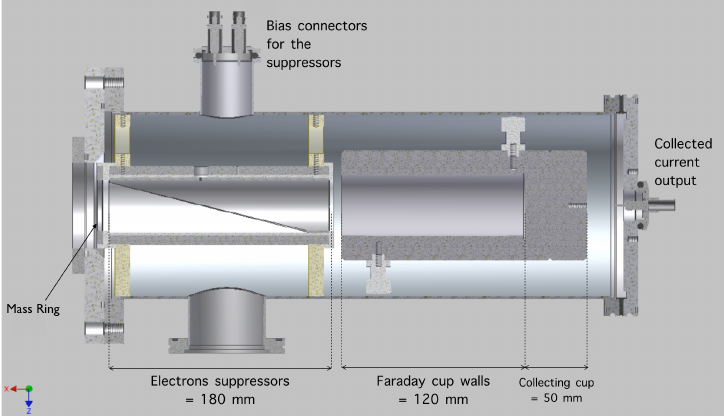
Figure 9. Technical drawing of the FC prototype realized at the